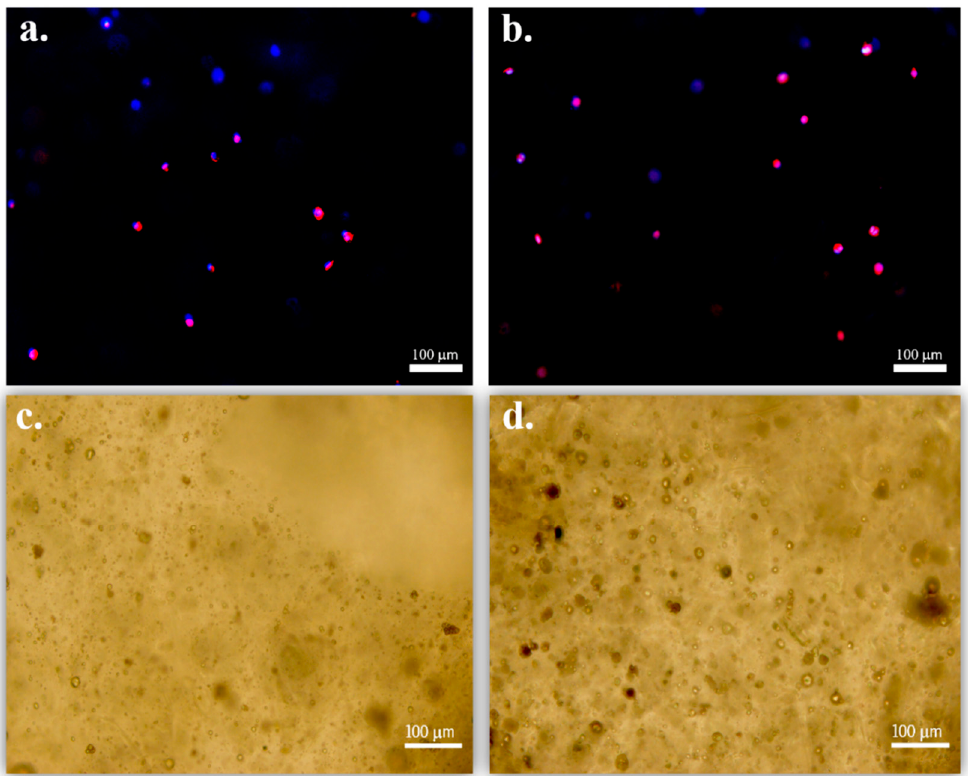
Figure 5. MC3T3-E1 adhesion to the hydrogel containing ( a ) neat and ( b ) magnetic microspheres after 24 h, under static conditions and in a 3D matrix cell culture; and ( c ) PLLA spheres and ( d ) CoFe 2 O 4 /PLLA spheres uniformly dispersed in the hydrogel.